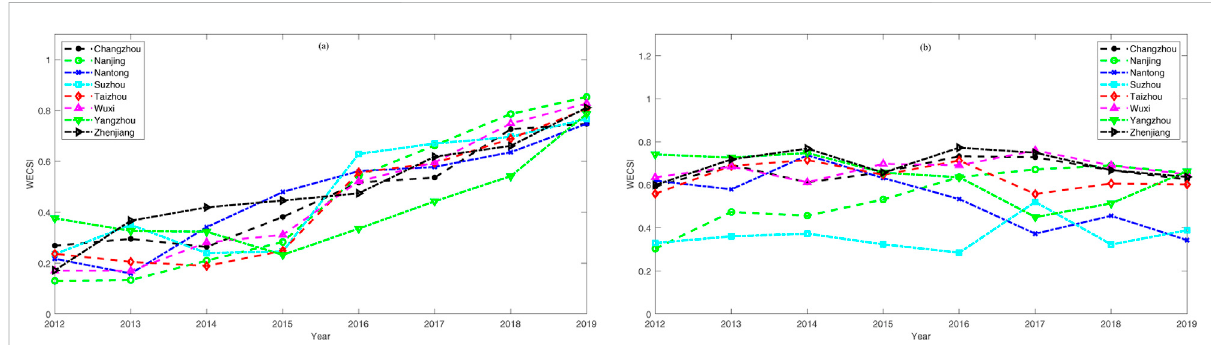
FIGURE 6 The variation of water environment carrying status index from city view (A) and horizontal year view (B) based on integrated